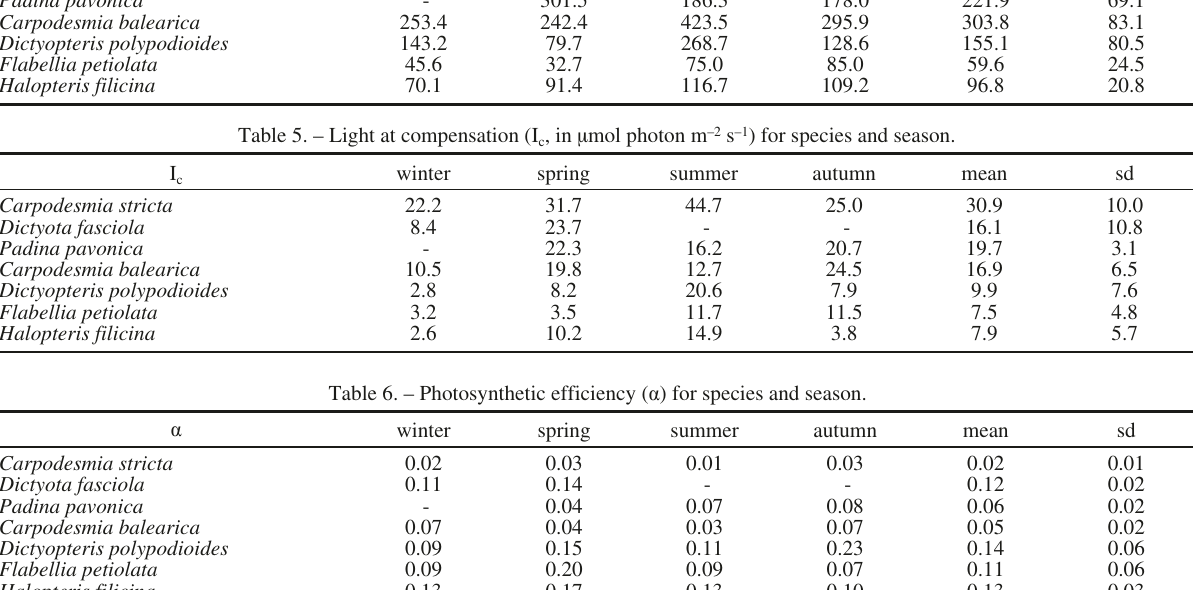
Table 4. – Light at saturation (I